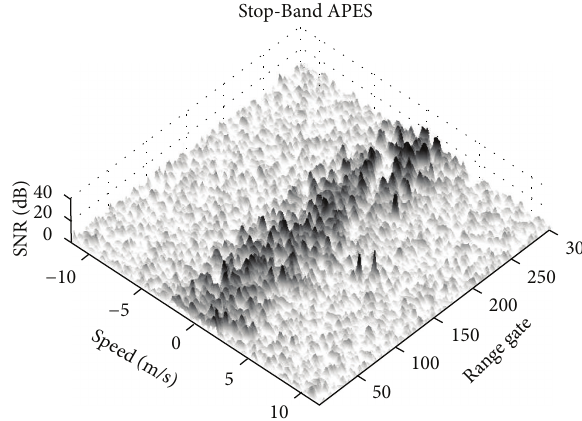
Figure 12: Range-Doppler map on RAMSES data showing the performance of the Stop-Band detector.